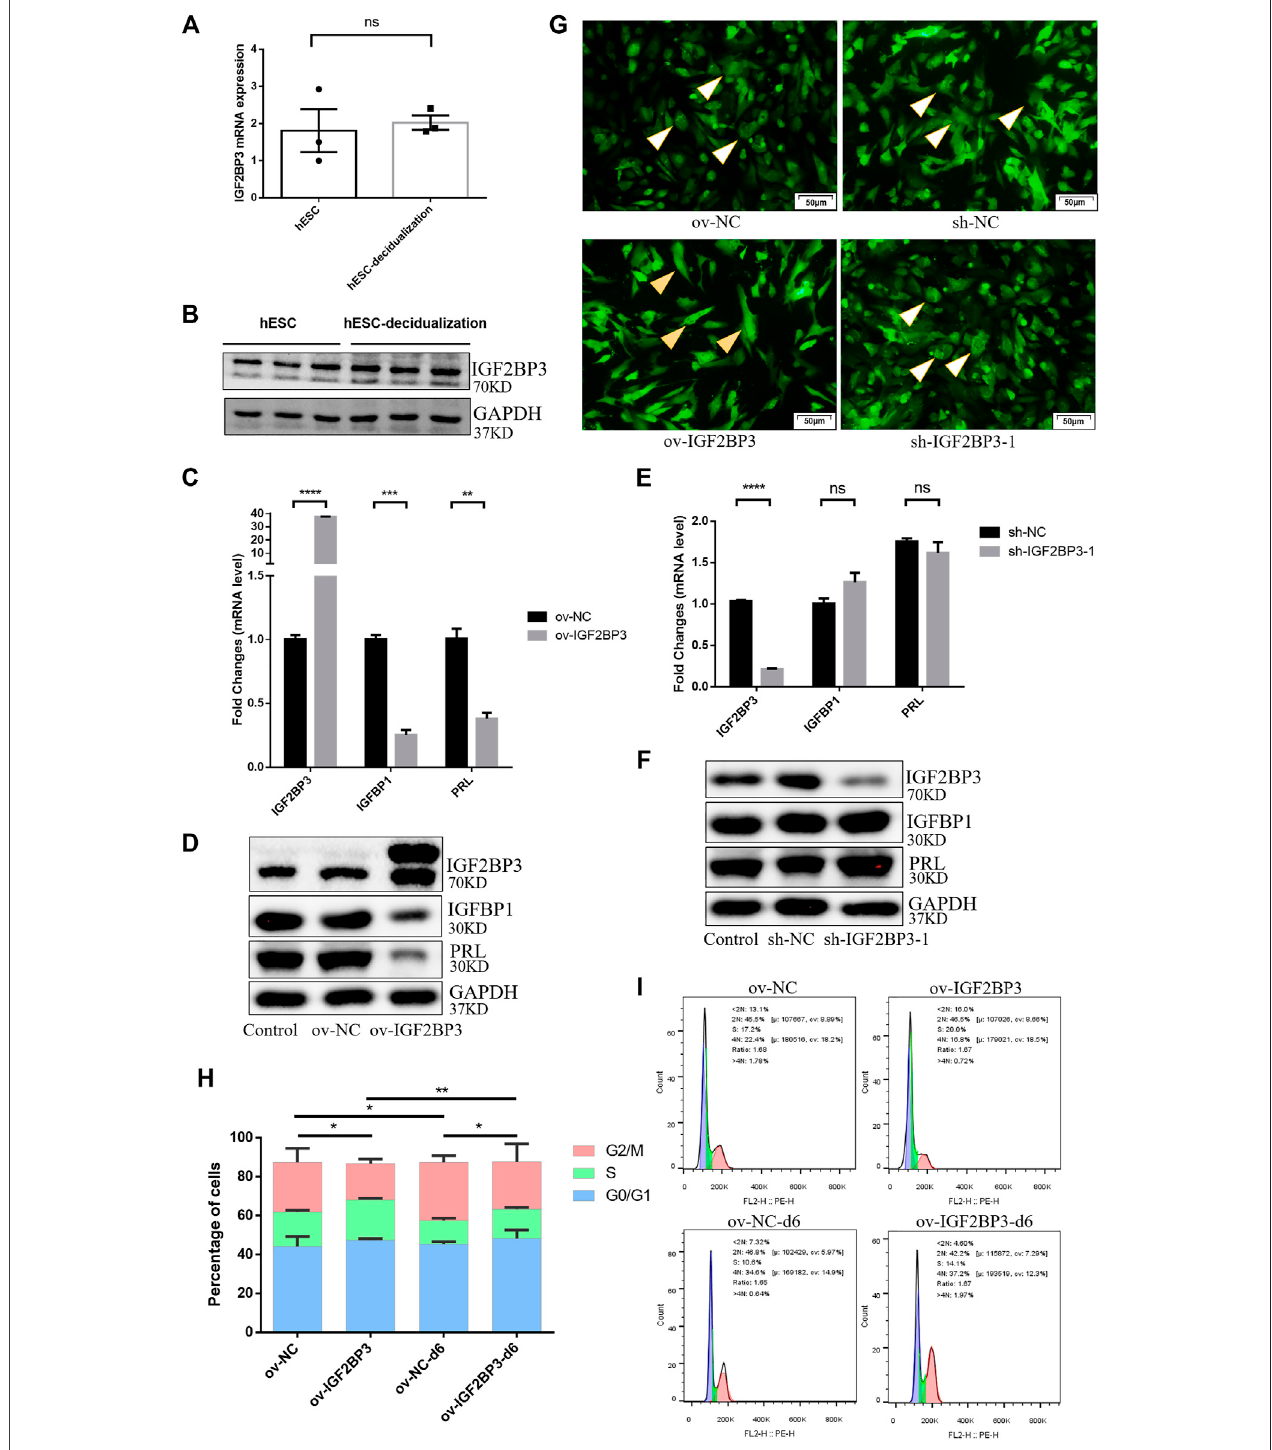
FIGURE2| RoleofIGF2BP3indecidualization (A,B) LevelsofIGF2BP3mRNAandproteininhESCswerenotsigni fi cantlydifferentwithcontrolcellsafterinduction of decidualization(MPA and db-cAMP added for 6 days), (C,D) IGF2BP3 overexpresscaused impaired decidualization ofhESCs.The decidualization markers (IGFBP1 and PRL) reduced in HESCs upon induction of decidualization in vitro after infected with ov-IGF2BP3, (E,F) IGF2BP3 knockdown did not affect the decidualization of hESCs. After in vitro induction ofdecidualization and after infection withIGF2BP3-1, the decidualization markers (IGFBP1 and PRL) in hESCs were notsigni fi cantly different compared with NC, (G) in fl uence of IGF2BP3 knockdown or overexpress on the cell morphology of HESCs after decidualization. Decidualization was induced